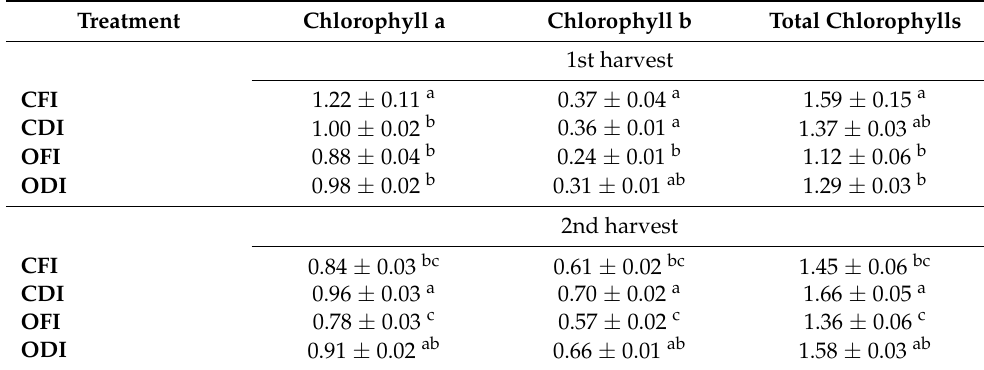
Figure 1. Effect of cultivation (conventional-C or organic-O) and irrigation (full irrigation-FI or deficit irrigation-DI) practices on Mellissa plants physiological parameters at two harvesting periods. Values represent mean (±SE) of measurements made on 6 independent replications per treatment. Mean values followed by the same letter do not differ significantly at p ≥ 0.05 according to Duncan’s MRT; ns: no significance. Table 2. Effect of cultivation (conventional-C or organic-O) and irrigation (full irrigation-FI or deficit irrigation-DI) practices on Mellissa plants content (mg/g Fw) for chlorophyll a, chlorophyll b and total chlorophyll under two harvestings.